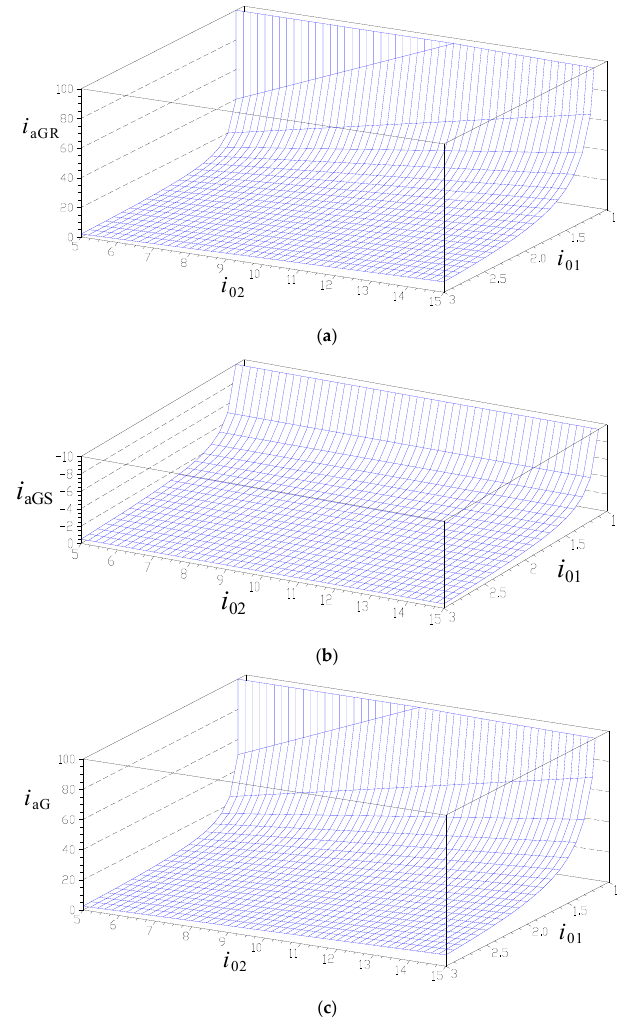
Figure 10. Variations of kinematic ratios ( a ) i a GR (from R1 to GR), ( b ) i a GS (from R1 to GS) and ( c ) i a G (from R1 to G in of counter-rotating electric generator) as functions of the interior kinematic ratios i 01 and i 02 .